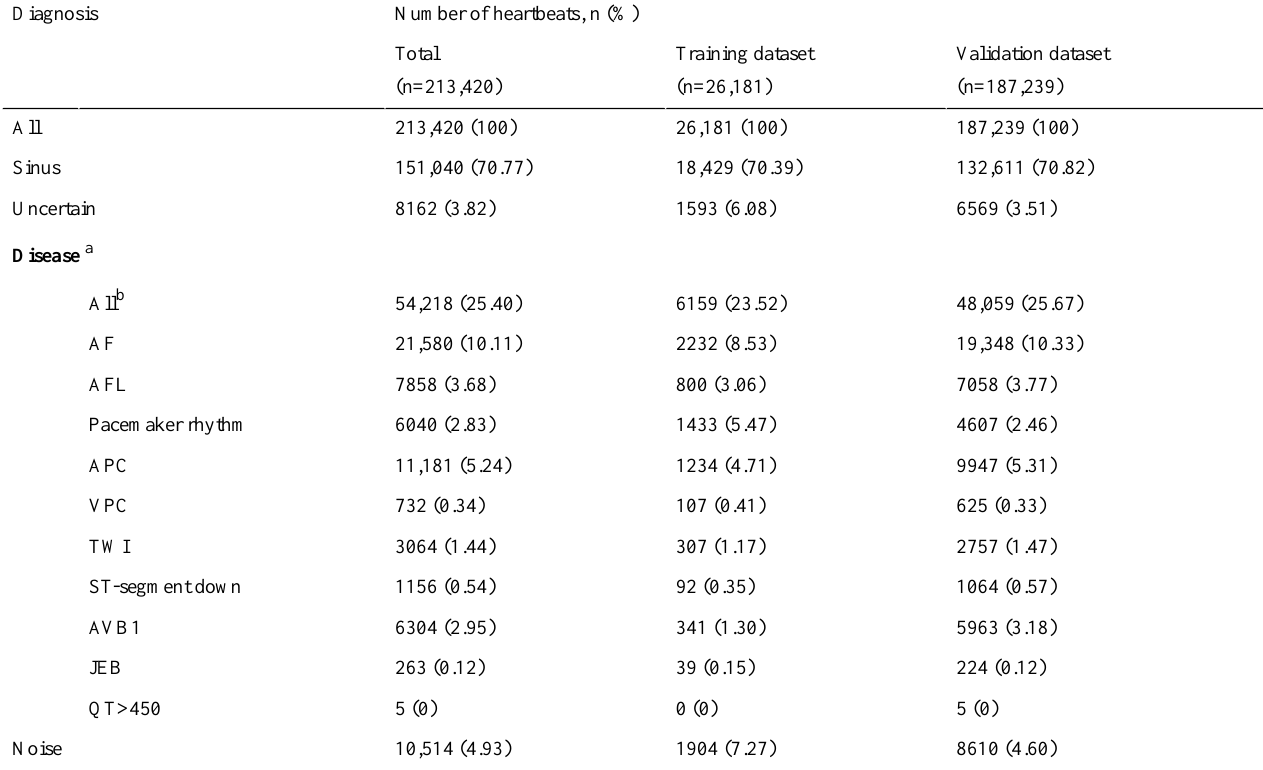
Table 3. Electrocardiogram dataset from 530 patients from the Telehealth Center of the National Taiwan University Hospital. Number of heartbeats, n